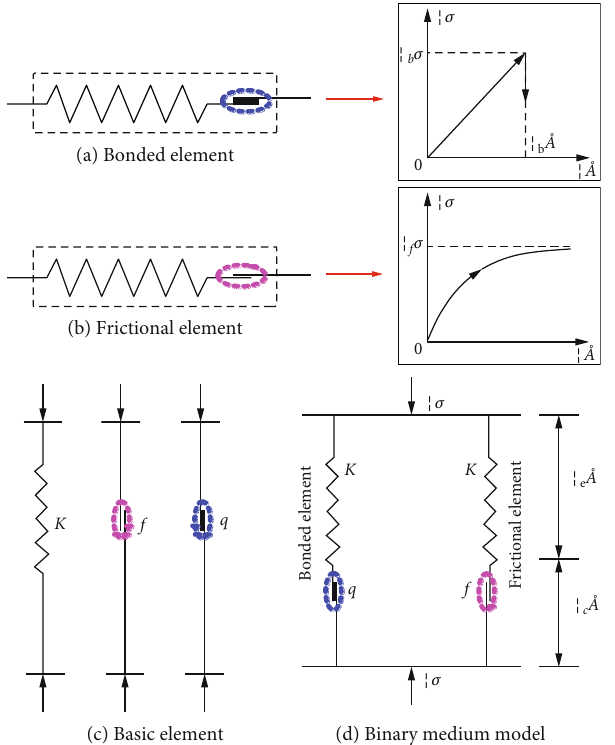
Figure 7: Simpli fi ed description of binary medium